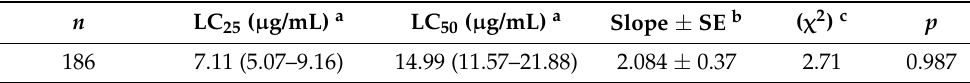
Figure 1. Gramine toxicity to BPH and effect of gramine on BPH nymph GST gene expression levels and GST activity. ( A ) Nymph mortality of BPH to gramine. ( B ) GST activity of BPH nymphs fed with different concentrations of gramine. ( C ) The expression level of GST gene in BPH nymphs after feeding on diets containing a nonlethal dose of gramine. Data are presented as mean ± standard error of mean (SEM) from 4 replicates. Different letters labeled indicate significant differences at p < 0.05. Table 1. LC 25 and LC 50 of gramine against BPH.